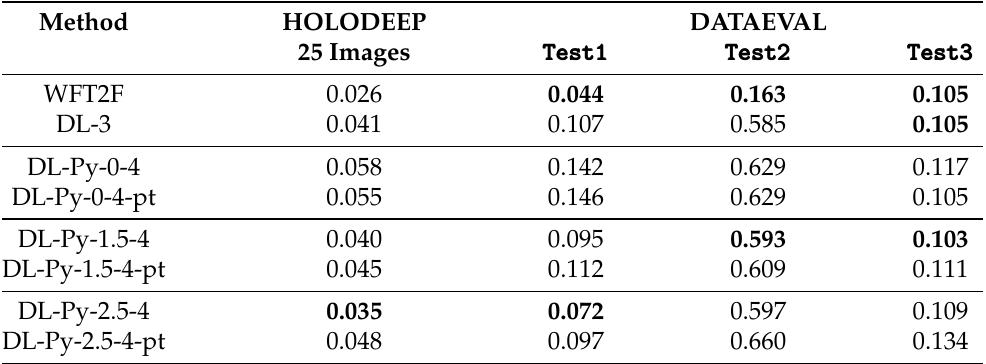
Table 4. ∆ φ (rad) obtained on the HOLODEEP database (in average) and individual images from DATAEVAL with one iteration. The best epochs for the pre-trained and trained models on the HOLODEEP validation